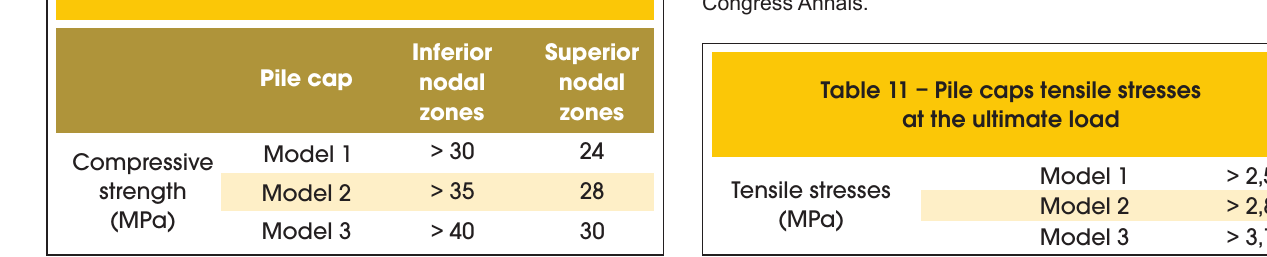
Table 10 – Compressive stresses in the nodal zones at the ultimate load